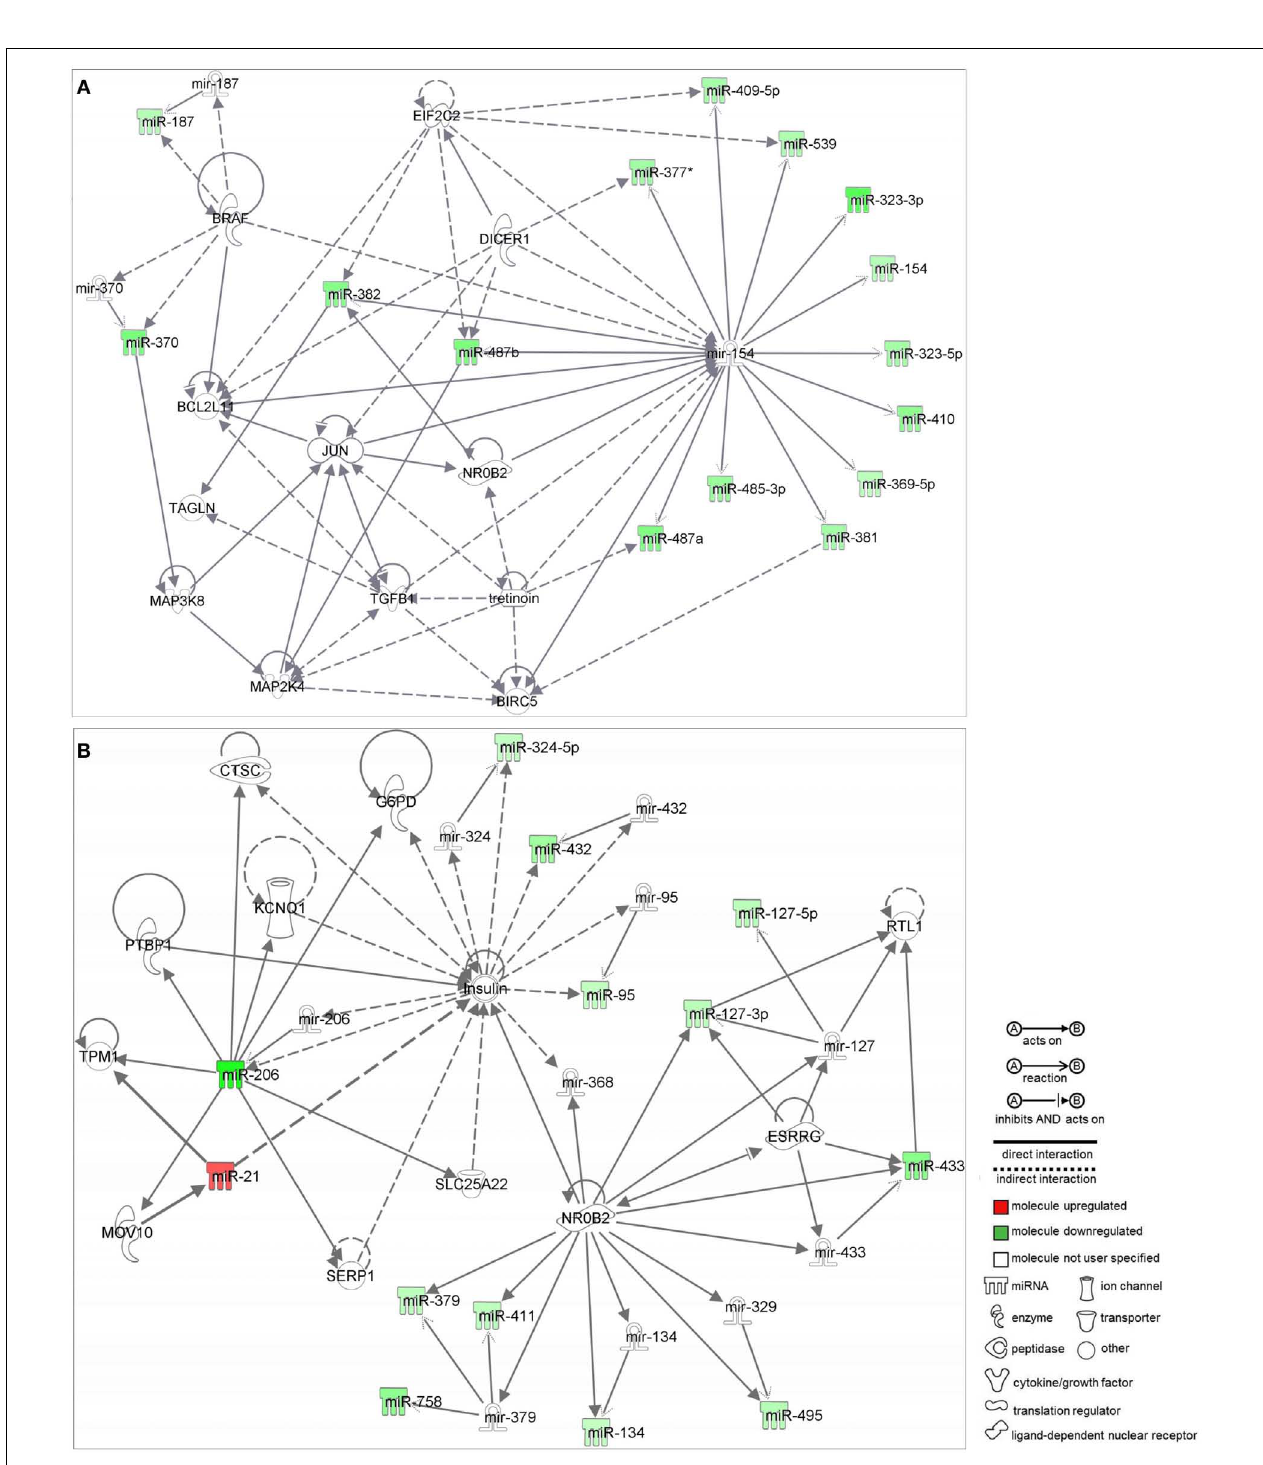
FIGURE 2 | Ingenuity pathway analysis networks (IPA) . (A) Network 1; (B) Network 2; both were constructed with deregulated miRNAs in medulloblastoma.